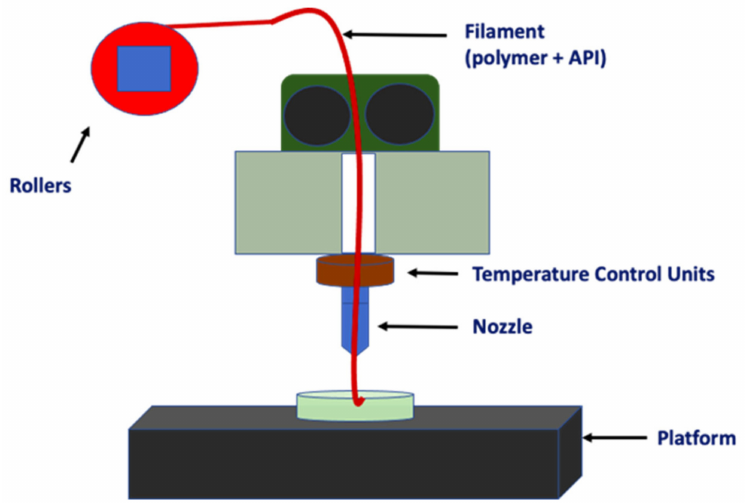
Figure 2. Fused Deposition Modelling (FDM)